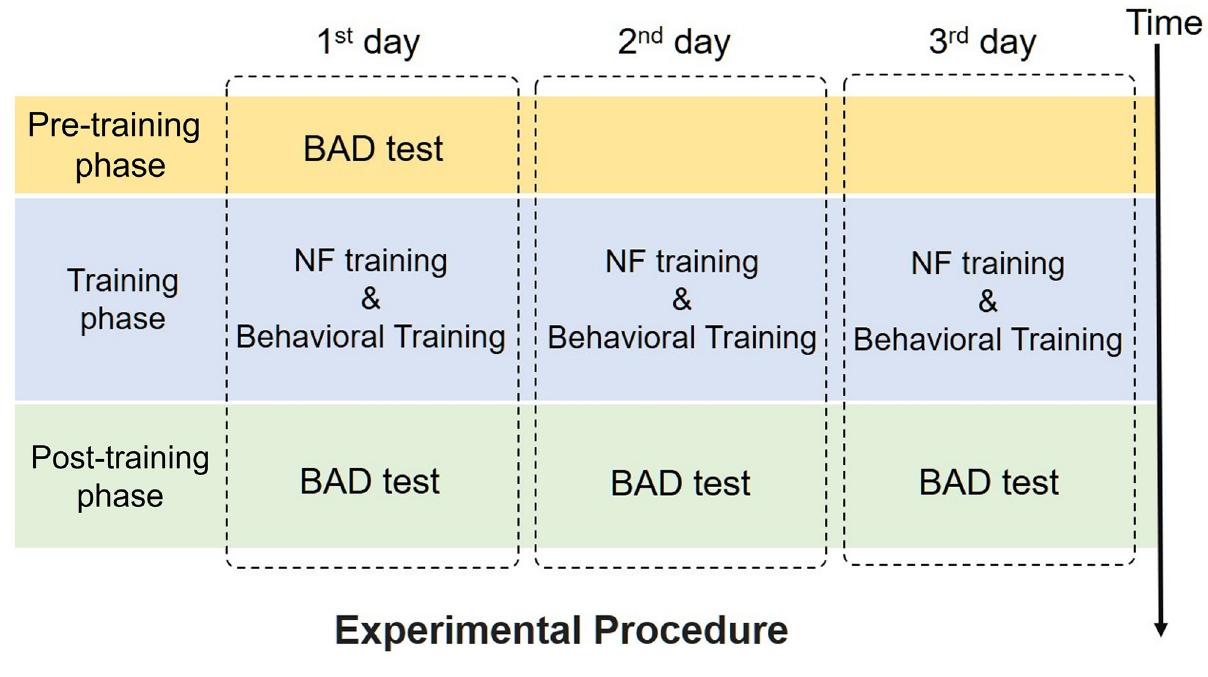
Fig 1. Overall study